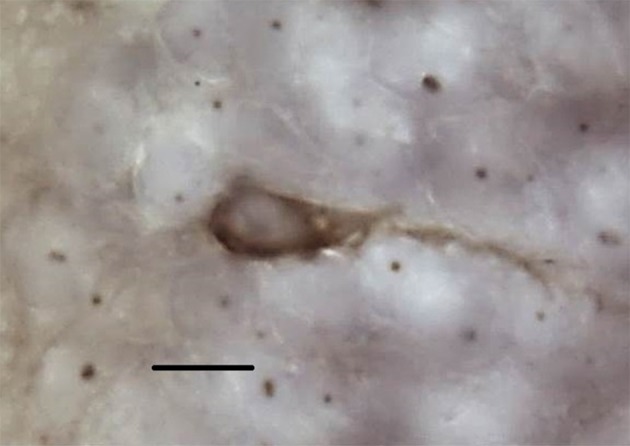
Representative doublecortin-positive cell at 100x. Scale bar = 10 μm.